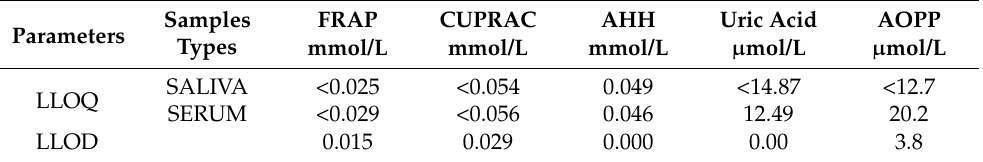
Table 3. The low limit of detection (LLOD) and low limit of quantification (LLOQ) in horse saliva and serum obtained for the ferric reducing ability of saliva/serum (FRAS/FRAP), cupric reducing antioxidant capacity (CUPRAC), Trolox equivalent antioxidant capacity (TEAC), uric acid, and advanced oxidation protein products (AOPP)